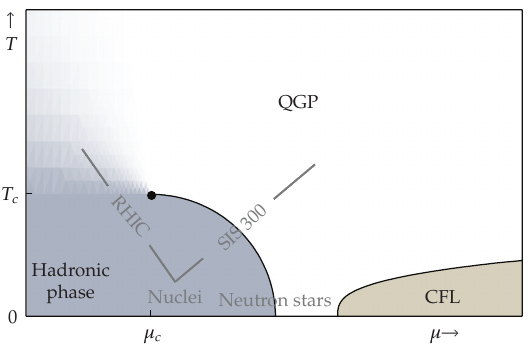
Figure 17: The conjectured QCD phase diagram in the plane of temperature T and baryon chemical poten- tial μ . The black lines indicate first-order phase transitions. The first-order confinement/deconfinement transition ends in a critical point at unknown (cid:2) μ c ,T c (cid:3) . Here the transition becomes second-order. Lattice simulations suggest 170MeV (cid:4) T c (cid:4) 190MeV, nuclear matter has μ ≈ 1GeV (cid:8) 157 (cid:9) . CFL is the color-flavor- locked